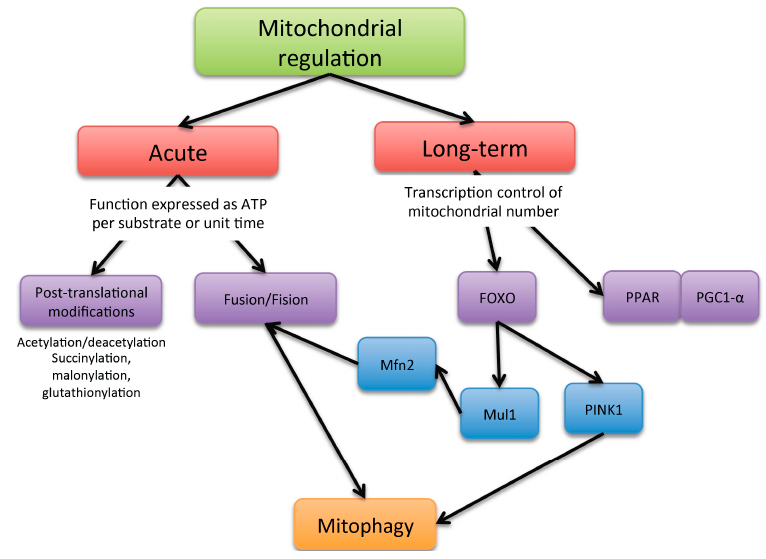
Figure 2. Scheme of the mechanism of mitochondria functioning regulation.